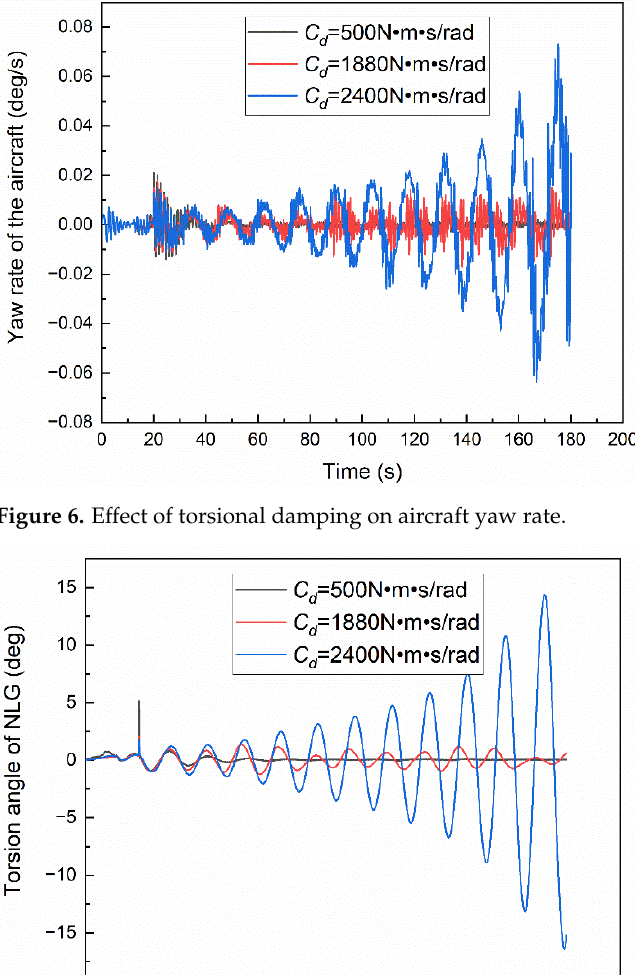
Figure 7. Effect of torsional damping on torsion angle of NLG.